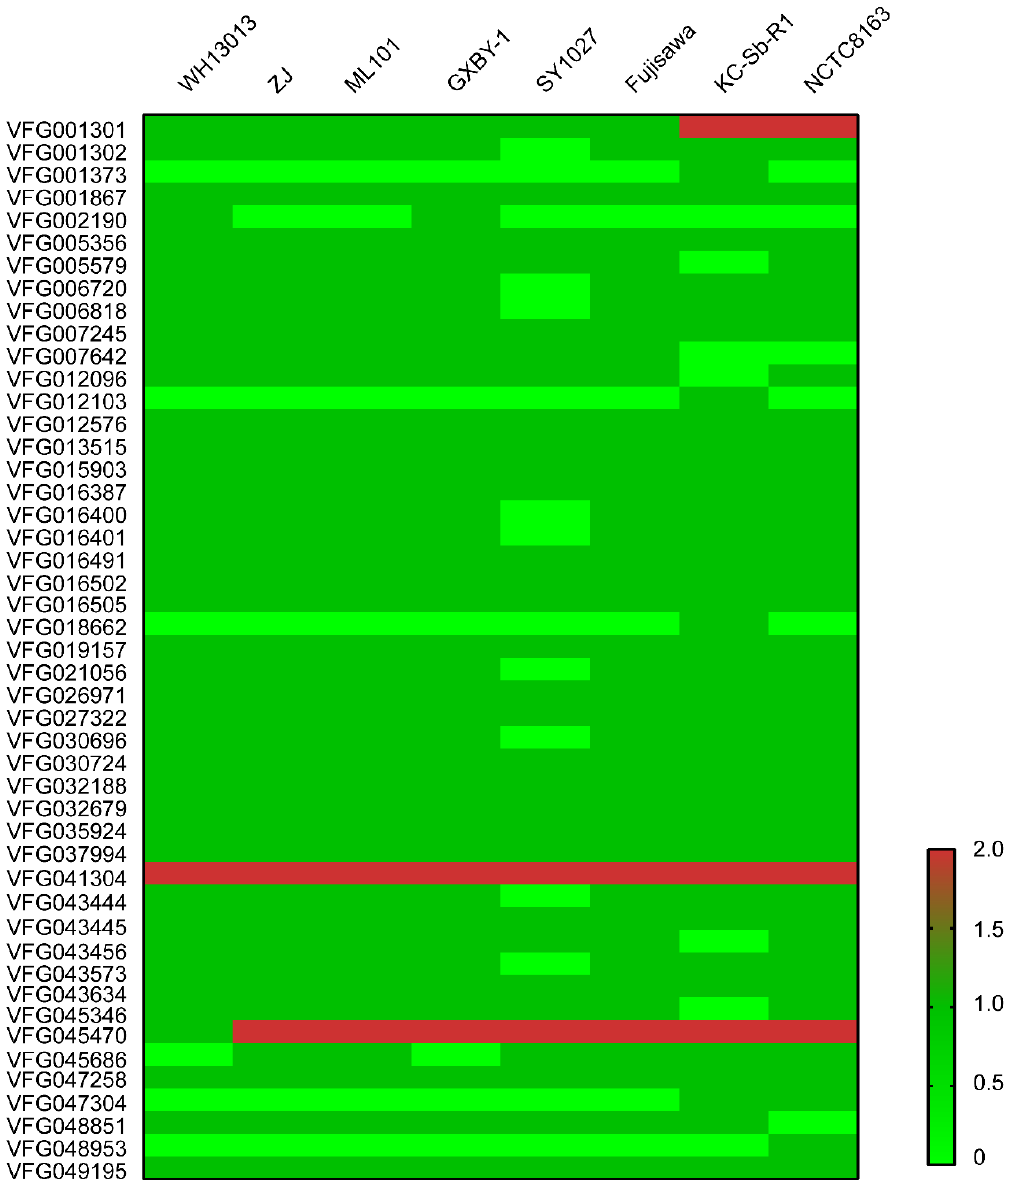
Figure 6 . Heatmap showing the distribution of predicted virulence factor-associated genes in different E. rhusiopathiae strains. Copies of resistance genes found in each of the genomes were shown in different shades of colors.